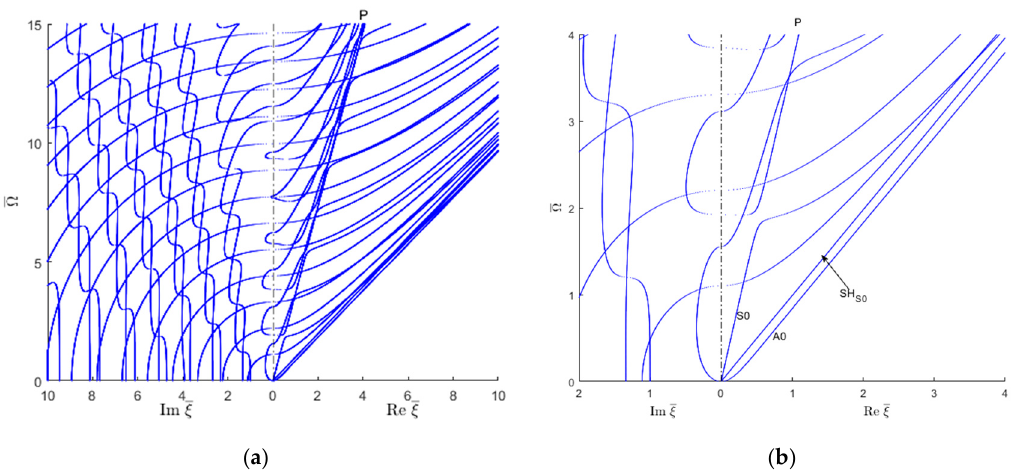
Figure 11. Real and imaginary wavenumber trajectories for low transverse stiffness, high shear stiffness, orthotropic transversely isotropic material: ( a ) overall plot; ( b ) zoom in near the origin.